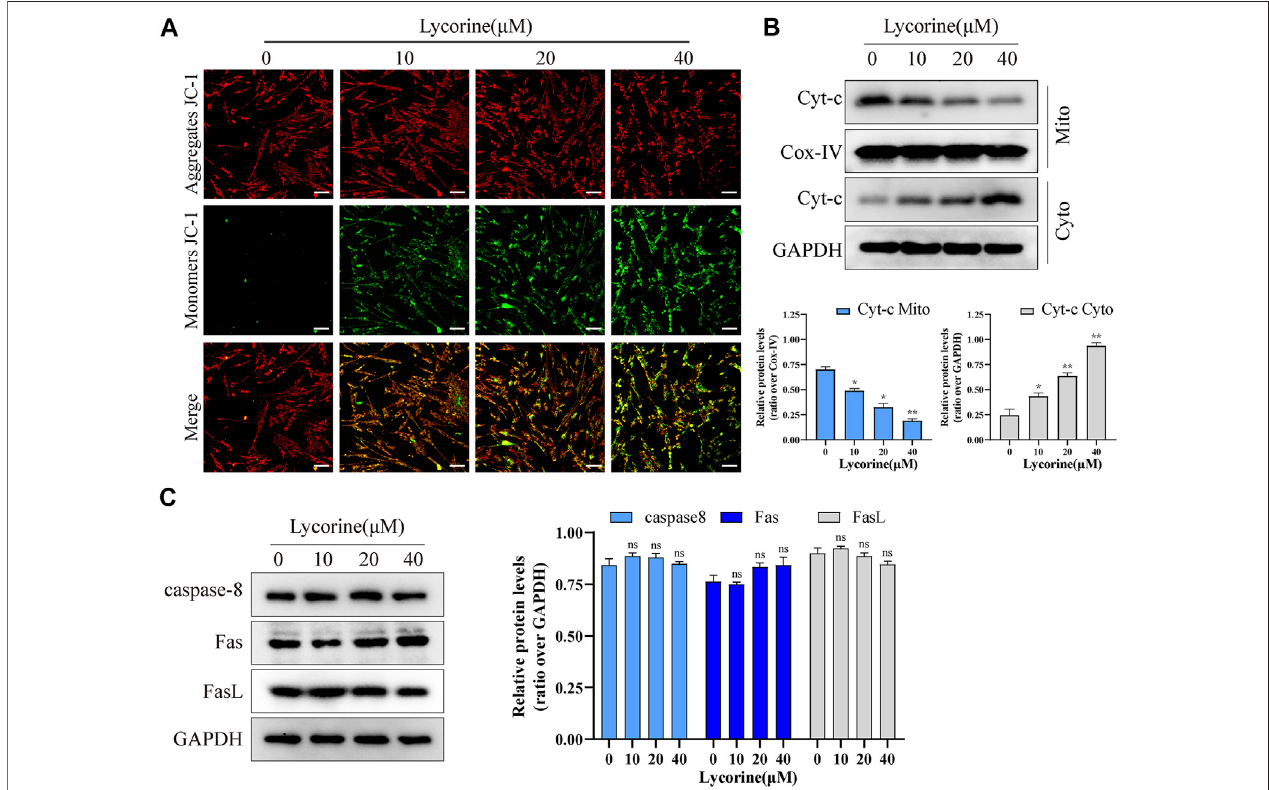
FIGURE 2 | Lycorine induced mitochondrial apoptosis of HSFs. (A) HSFs were treated with vehicle or lycorine for 24 h, and the mitochondrial membrane potential (MMP) was analyzed by fl uorescent imaging after staining the cells with JC-1 ( n = 3). Scale bar: 200 μ M. (B) At 24 h post lycorine treatment, the relative levels of CytochromeC(cyt-C)inboththecytoplasmandmitochondriawereexaminedbyWesternblot( n =3). (C) At24 hpostlycorinetreatment,therelativelevelsofcaspase8, Fas, Fasl to the control GAPDH expression in NFs were examined by Western blot ( n = 3). Data are mean ± standard error of the